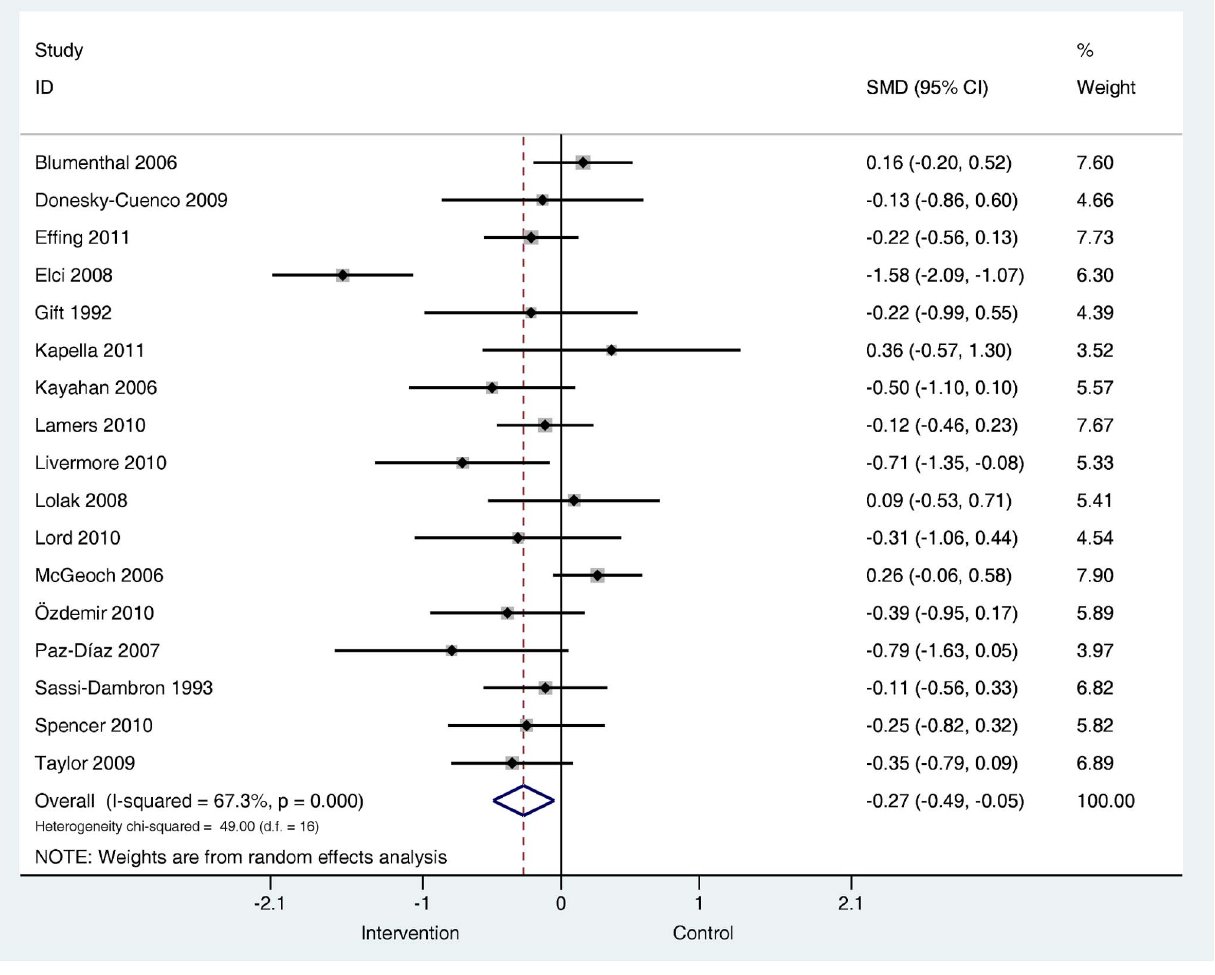
Figure 13. Effects on self-reported symptoms of anxiety in trials where severity of anxiety was unknown at baseline. Note: Random effects model used. 95% CI=95% confidence intervals; SMD=standardised mean difference.